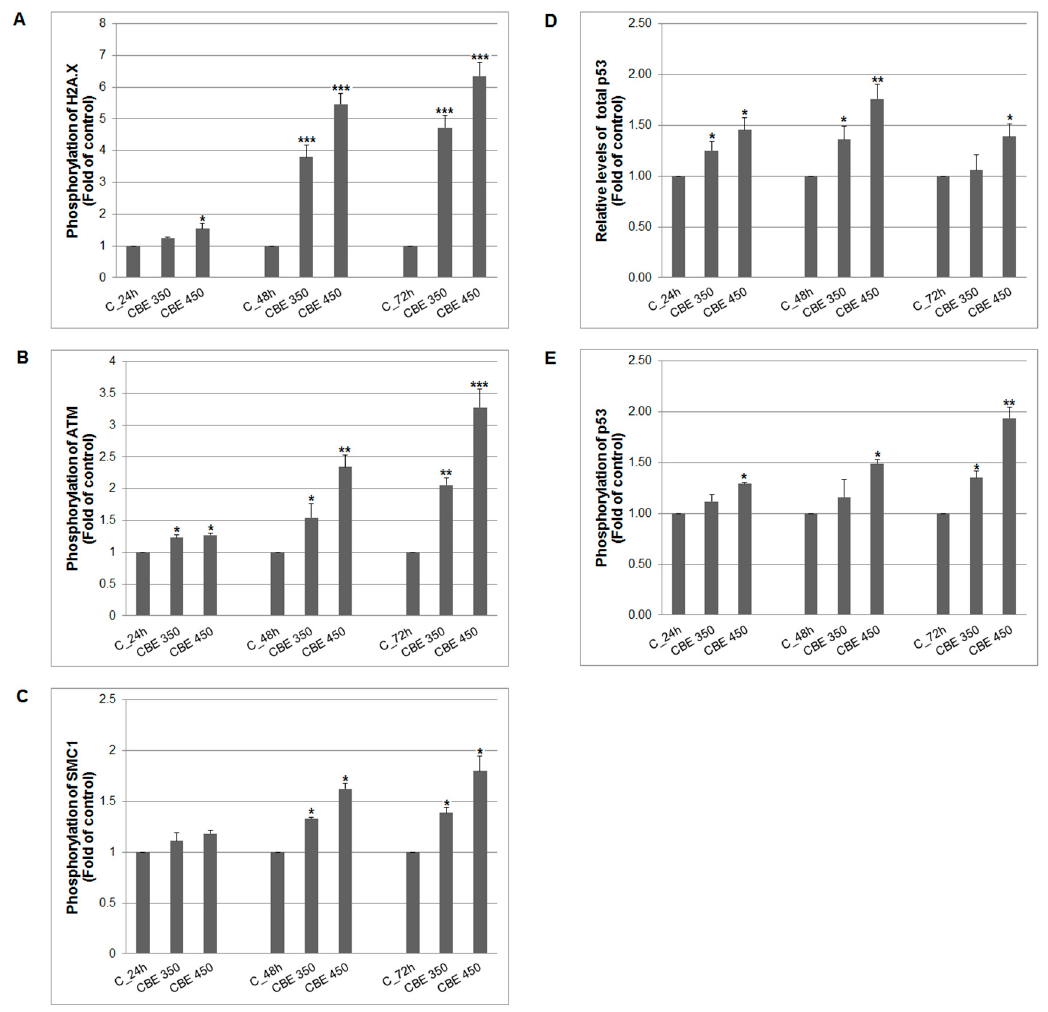
Figure 4. Effect of CBE on phosphorylation status of ( A ) histone H2A.X, ( B ) ATM kinase, ( C ) SMC1 kinase and ( D , E ) p53 activity in MCF-7 cells. Data were obtained from three independent flow cytometry experiments after 24, 48 and 72 h CBE treatment. Significance: * p < 0.05, ** p < 0.01, *** p < 0.001 vs. untreated cells (control).